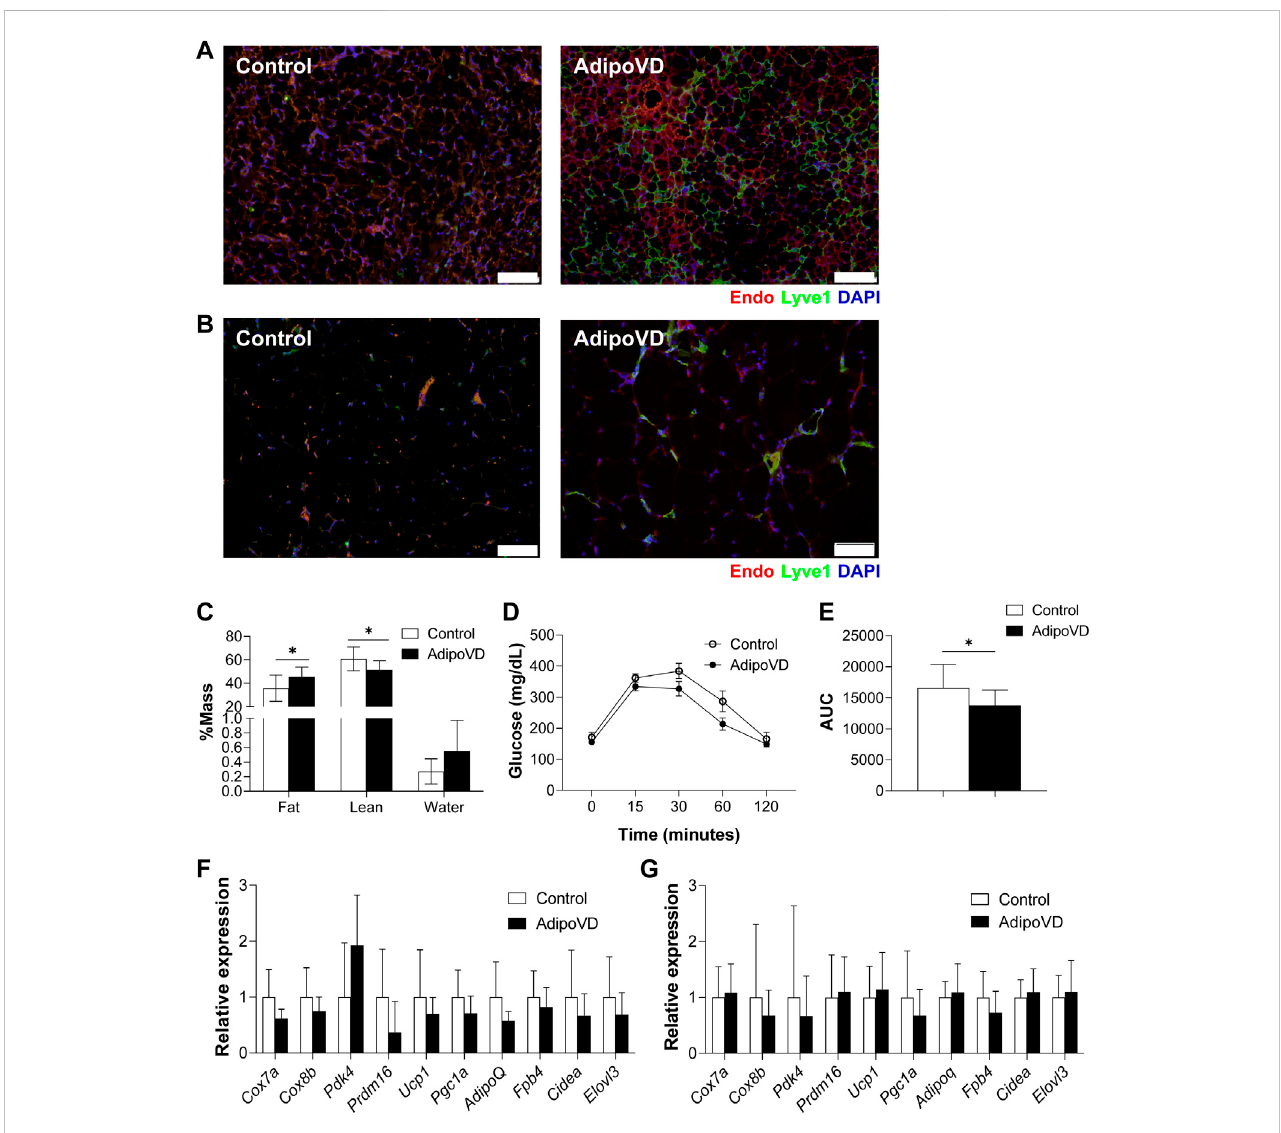
FIGURE 1 Overexpression of VEGF-D expands adipose lymphatic density but does not impact overall adipose tissue physiology. (A) : Immuno fl uorescence of lymphatic (green; LYVE-1) and blood (red; Endomucin) in brown adipose tissue (BAT) of Control and AdipoVD mice. (B) Immuno fl uorescence of lymphatic (green; LYVE-1) and blood (red; Endomucin) insubcutaneous white adipose tissue (SQAT) ofControl andAdipoVD mice. (C) Body compositionquanti fi cation of Control and AdipoVD mice by magnetic resonance. (D) Serum glucose levels during an oral glucose tolerance test in Control and AdipoVD mice. (E) Average area under the curve (AUC) calculated from glucose levels of oral glucose tolerance test. (F) Browning and thermogenesis-associated gene expressioninAdipoVDBATrelativetoControls. (G) Browningandthermogenesis-associatedgeneexpressioninAdipoVDSQATrelativetoControls. (A – E) n = 10 control/n = 7 AdipoVD. (F – G) ; n = 11 for control and AdipoVD. Blue = DAPI. Bars = 100